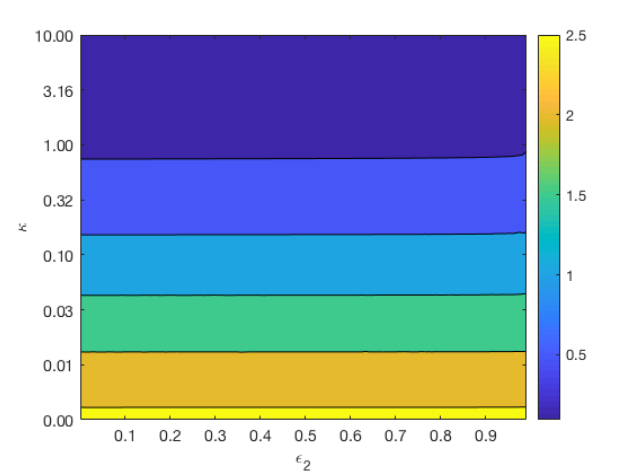
Figure 7. Contour map of the dimensionsionless T α for κ against ε 1 with ε 2 = 0.4 ( top ) and κ against ε 2 with ε 1 = 0.6 ( bottom ) in spherical geometry. The remaining parameters are listed in Table 4 and S 0 = 1.